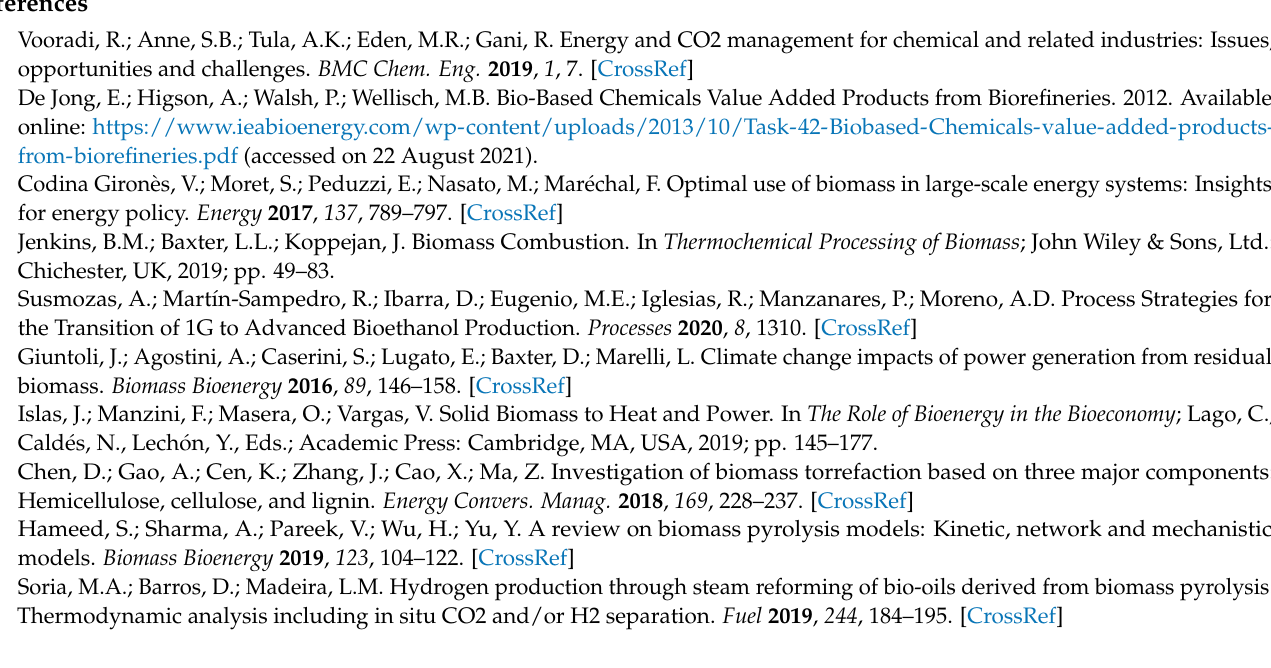
heating ratio. Figure S2: TGA and DTG for Ulmus minor cellulose sample at different heating ratio. Figure S3: TGA and DTG for Linun usitatissimun cellulose sample at different heating ratio. Figure S4: TGA and DTG for Olea europaea cellulose sample at different heating ratio. Figure S5: TGA and DTG for Robinia pseudoacacia cellulose sample at different heating ratio. Figure S6: TGA and DTG for Populus alba cellulose sample at different heating